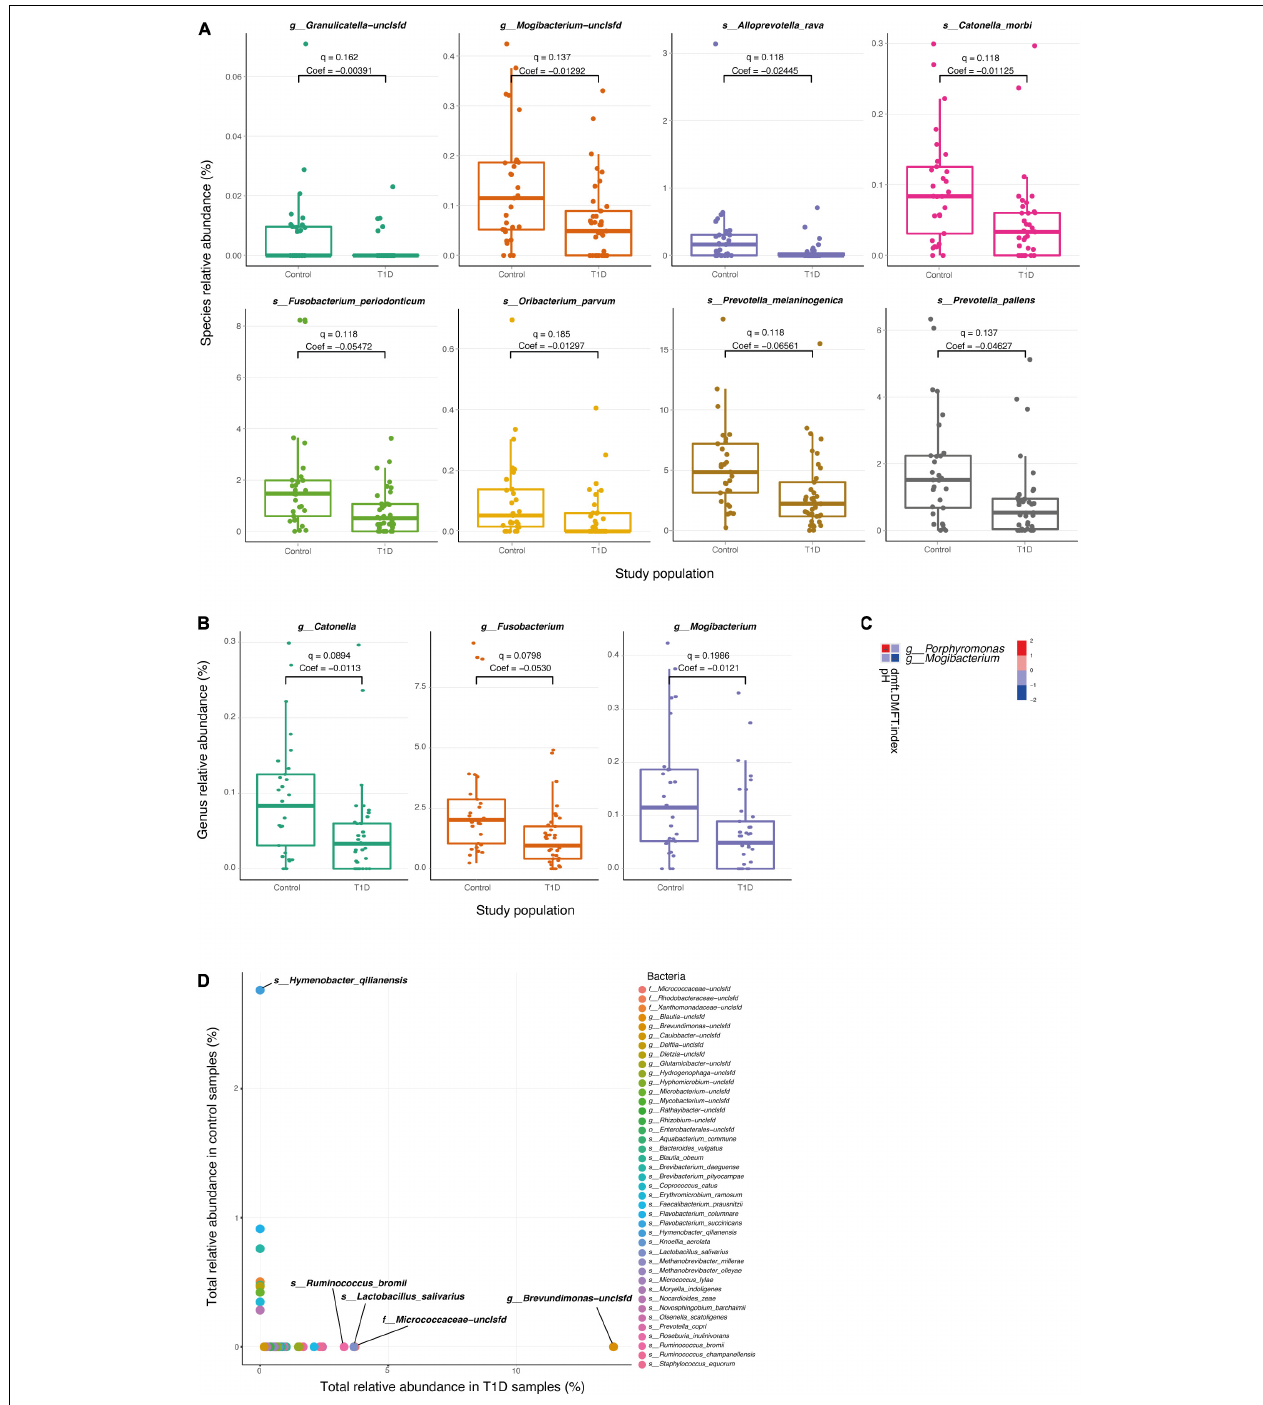
FIGURE 2 | Differential microbial taxa between T1D samples and controls. (A,B) Relative abundance of the significant taxa at the species (A) and genus (B) level, in T1D samples and control samples. Q -values and coefficients calculated using a multivariate linear regression model (MaAsLin, see section “Materials and Methods). The boxes represent the interquartile range (IQR) between the first and third quartiles (25th and 75th percentiles, respectively) and the vertical line inside the box defines the median. (C) Significant associations between microbial taxa and clinical parameters of the oral cavity. Only salivary pH and DMFT index are shown in the vertical axis as significantly correlated parameters ( q < 0.25), and two genera; Porphyromonas and Mogibacterium , are shown in the horizontal axis. The variations in color are the magnitude of correlation between both variables. Correlation coefficient values range between − 1.0 and 1.0; a correlation coefficient that is greater than zero indicates a positive relationship between two variables, a value that is less than zero signifies a negative relationship between two variables. (D) Relative abundance species apparent in only one type of population. The horizontal axis represents the sum of the relative abundance of the bacteria in T1D samples. The vertical axis represents the sum of the relative abundance of the bacteria in control